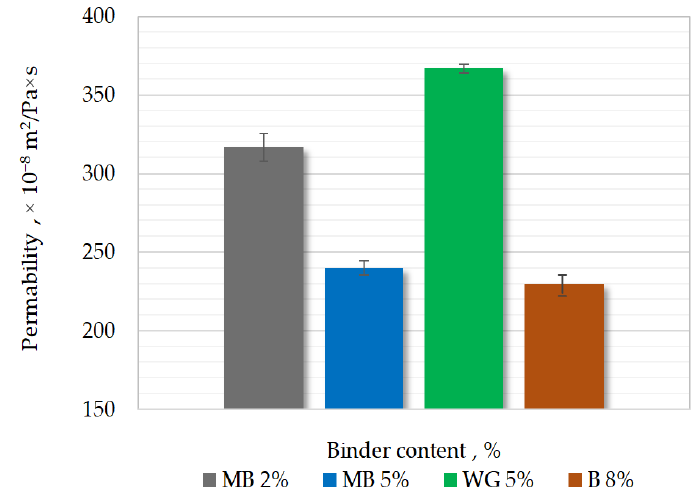
Figure 8. Results of permeability measurements of different molding sands.